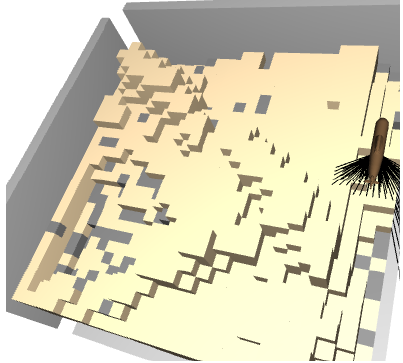
Figure 10. Distribution of litter for the experiment. More litter (gray voxels) was placed in the deeper layers (valleys) than in the higher